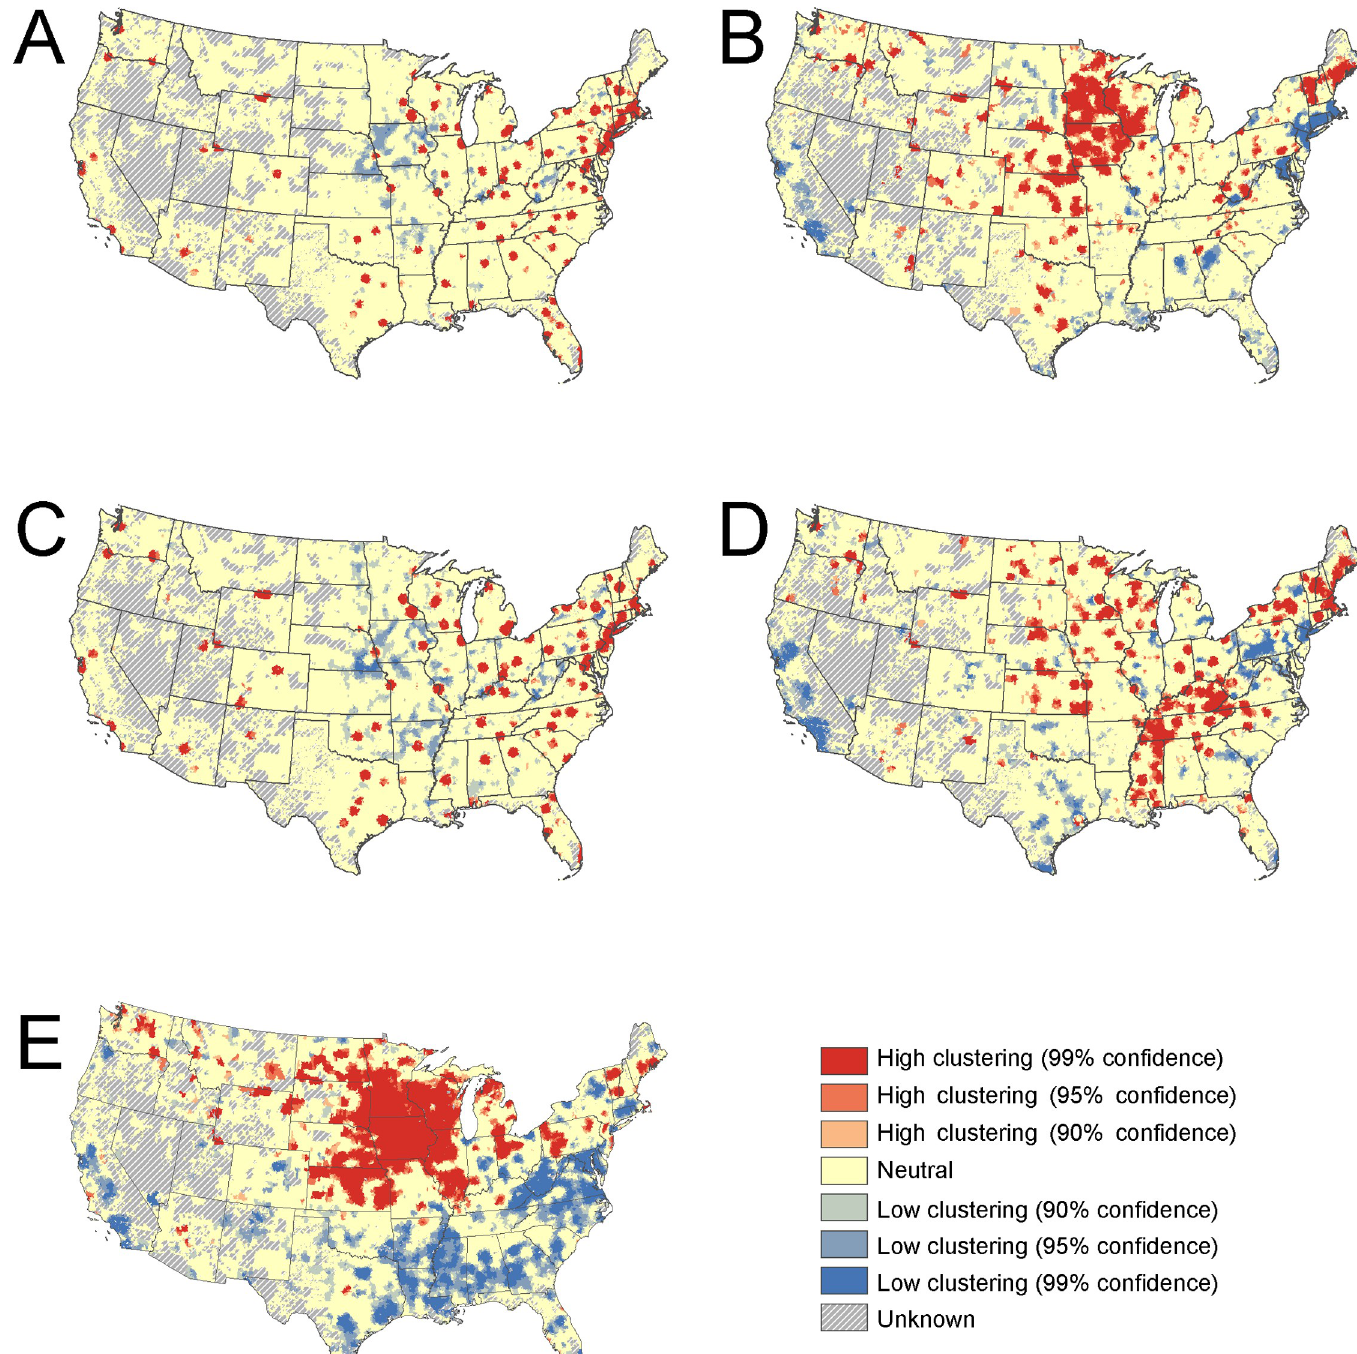
Fig 2. Provider Getis-Ord Gi � statistic. Getis-Ord Gi � statistic for internal medicine physicians (A), family medicine physicians (B), specialists (C), nurse practitioners (D), and chiropractors (E) across the contiguous United States.